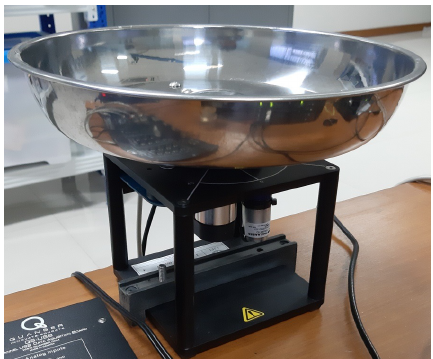
Figure 6. Experimental validation with DC